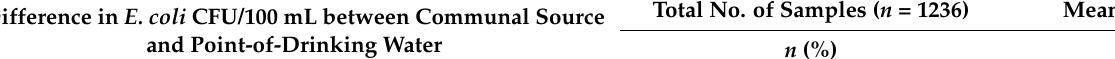
Table 2. Difference in E. coli CFU/100 mL of water between the paired samples of communal source water and point-of- drinking water collected on the same